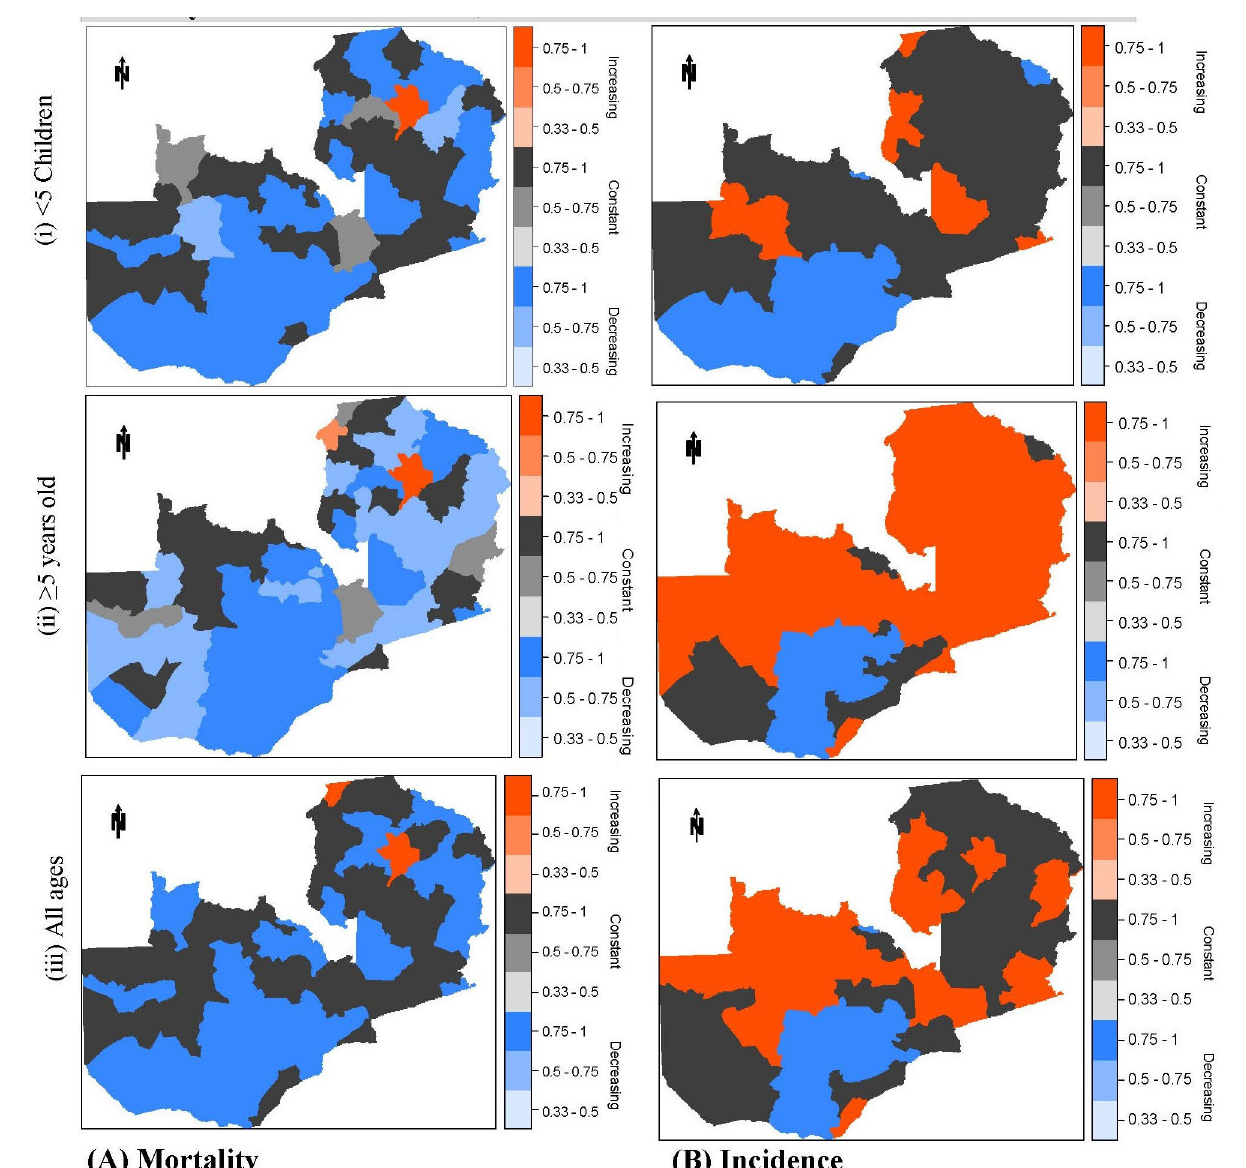
Fig 5. Temporal trend of malaria under-five children and over five age group mortality and incidence trends, 2000–2015. The red trend shows increasing , the blue trend shows declining , and the black trend shows constant/no change . Classifications are based on the maximum posterior probabilities: the darker/deeper the shading, the higher the posterior probability for that trend and vice versa. Fig 5(iii) is also published elsewhere